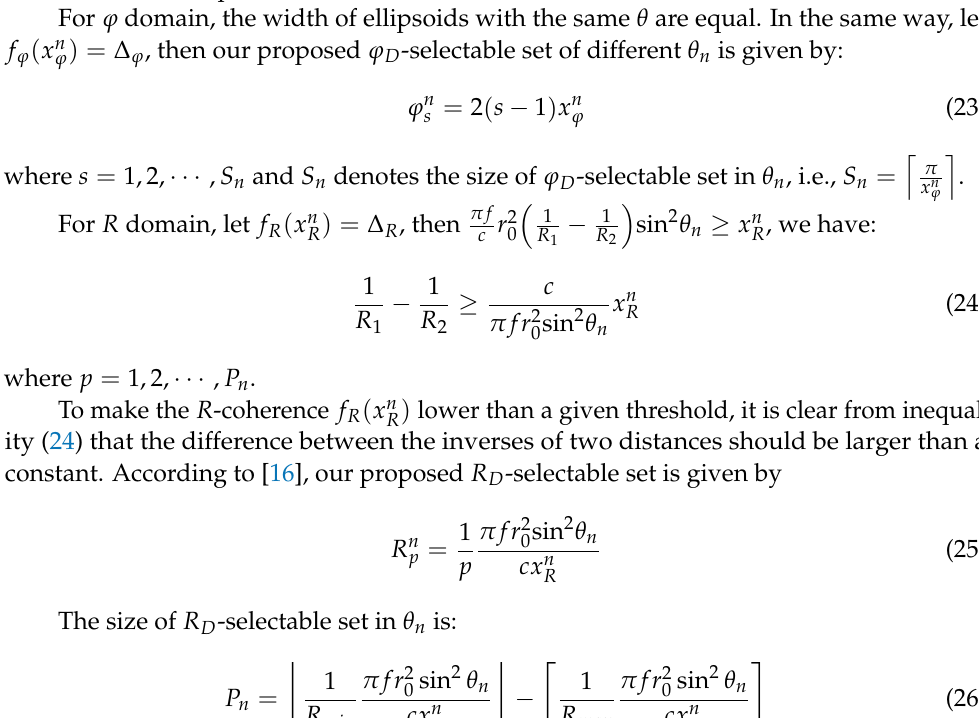
Figure 7. The numerical results with the same θ and f of ( a ) f ϕ ( x ϕ ) against x ϕ . ( b ) f R ( x R ) against x R . We can see that Functions (17) and (20) have similar properties to the Bessel function (Function (15)) in that get the maximum value at zero and decrease with swings with the increase in the independent